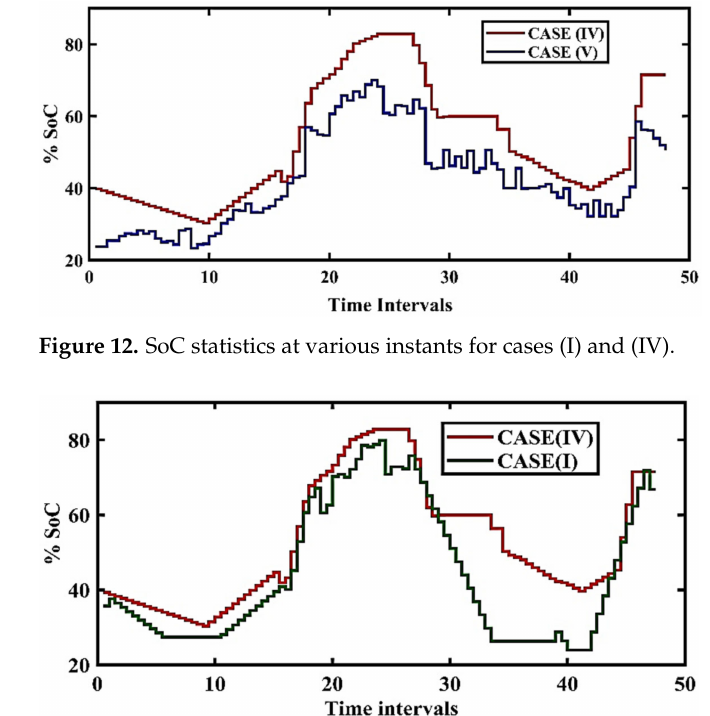
Figure 13. SoC statistics at various instants for cases (IV) and (V).